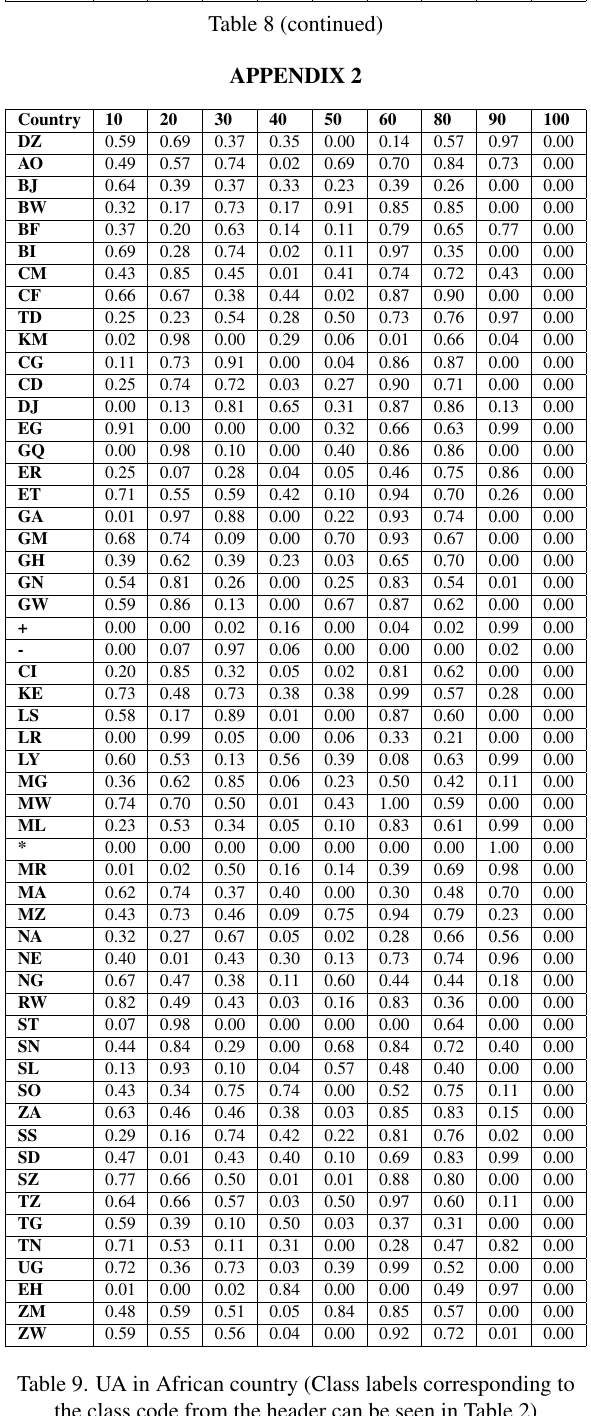
Table 8. PA in African countries (Class labels corresponding to the class code from the header can be seen in Table 2)